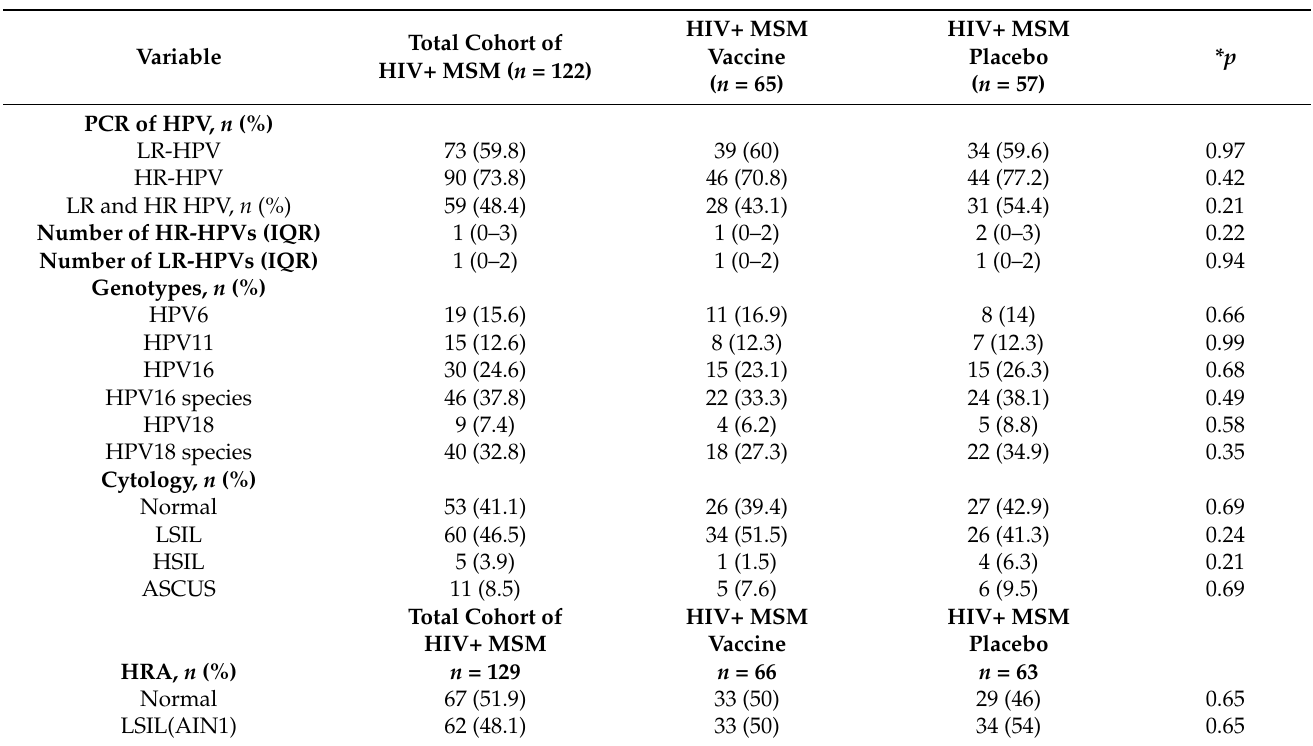
Table 2. Baseline human papillomavirus (HPV) PCR, cytology, and high-resolution anoscopy (HRA) * results in the study population.